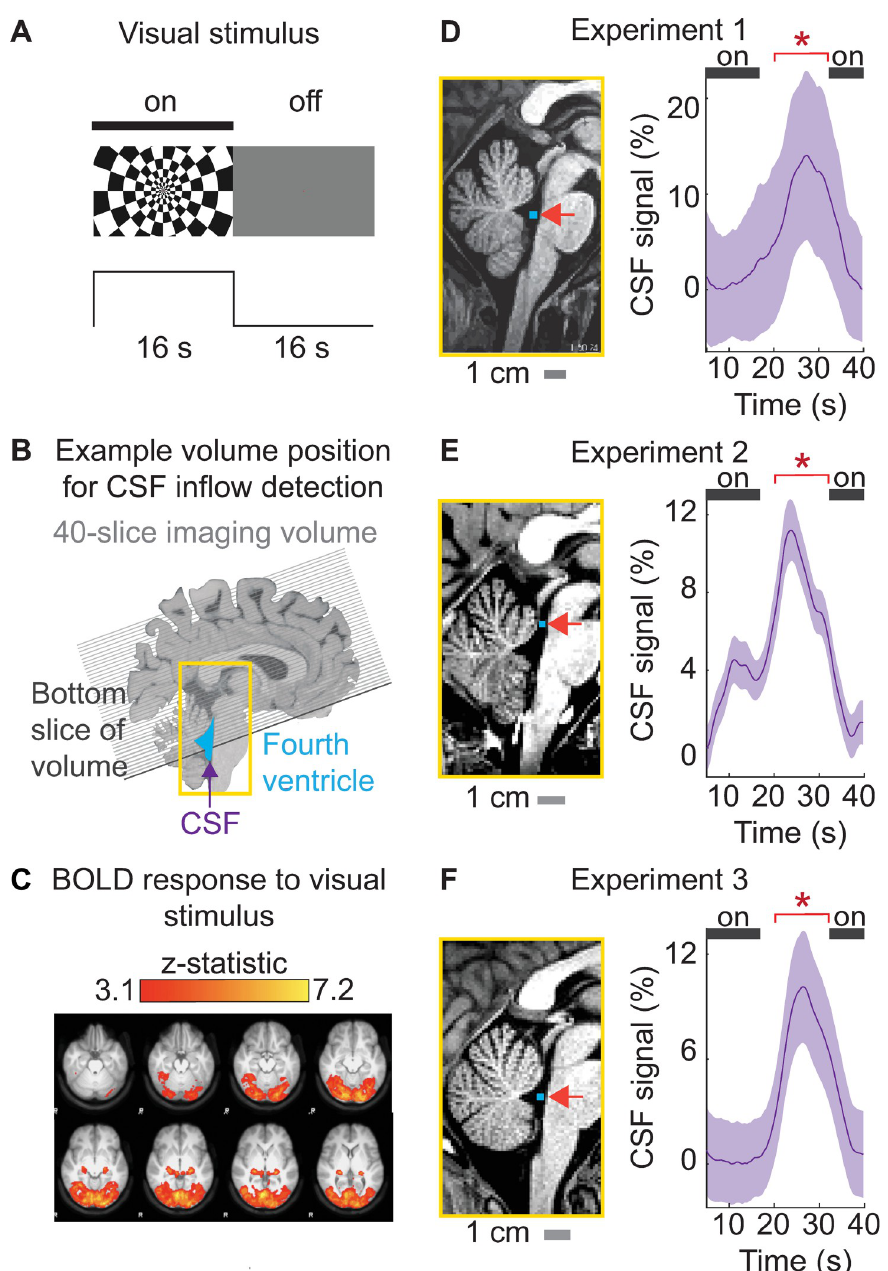
Fig 1. High-intensity visual stimulation drives significant cerebrospinal fluid inflow in the fourth ventricle and aqueduct. AU : AbbreviationlistshavebeencompiledforthoseusedinFigs 1 to 4 : Pleaseverifythatallentriesarecorrect : ( A ) Example frames from the block-design visual stimulus. “On” blocks consisted of a flickering radial checkerboard. “Off” blocks consisted of a gray screen. ( B ) The analysis extracted the CSF inflow signal measured in the fourth ventricle (blue) moving upwards (purple arrow) into the functional acquisition volume. The black line indicates an example position of the bottom slice of functional volume through the fourth ventricle, to enable upwards CSF flow detection. (C) Map in MNI space of widespread cortical activation in response to block-design checkerboard visual stimulus in n = 16 subjects in Experiment 3. Z-statistic values were thresholded at a level of 3.1 and corrected voxel- wise for multiple comparisons ( p < 0.05). ( D ) Left: Example placement of CSF ROI (blue) in the fourth ventricle in 1 subject in Experiment 1. Right: Average evoked CSF inflow signal locked to the visual stimulus across subjects in Experiment 1 ( n = 6). ( E ) Left: Example placement of the CSF ROI in Experiment 2, in the upper ventricle and aqueduct. Right: Average evoked CSF inflow signal across subjects in Experiment 2 ( n = 20). ( F ) Left: Example placement of CSF ROI in Experiment 3, in the fourth ventricle. Right: Average evoked CSF inflow across subjects in Experiment 3 ( n = 16). The black bar indicates “on” blocks. Shading indicates standard error across subjects. The time